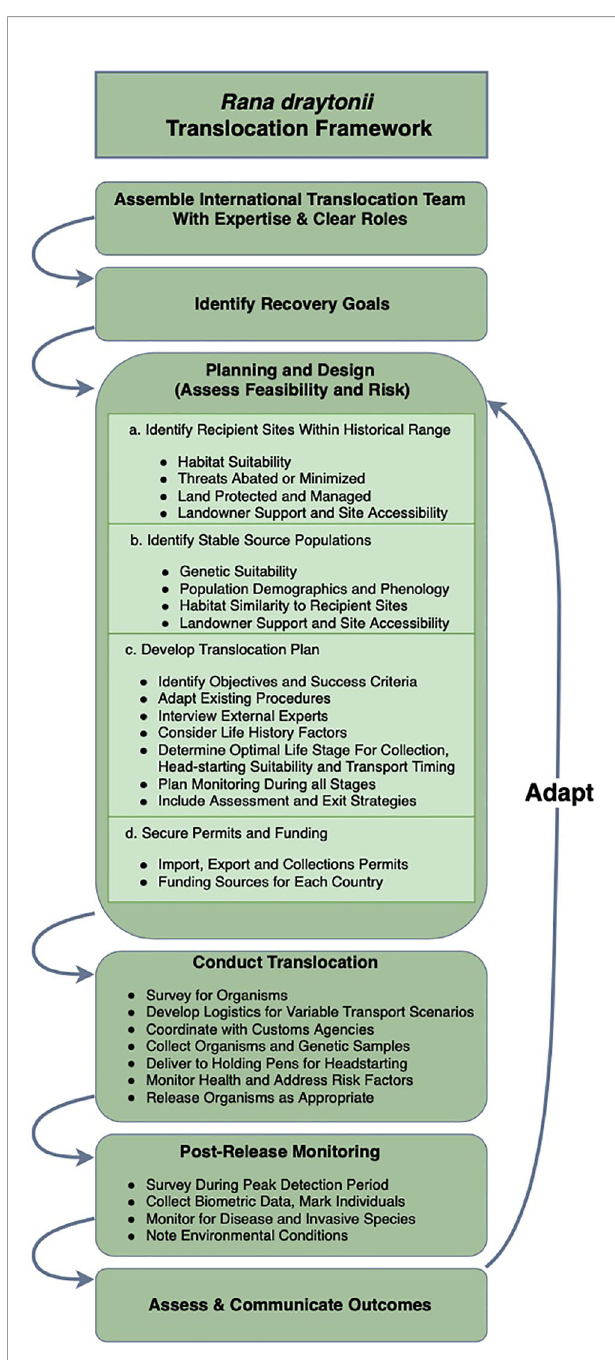
FIGURE 4 | Process fl owchart for reintroduction of Baja California Lineage of Rana draytonii